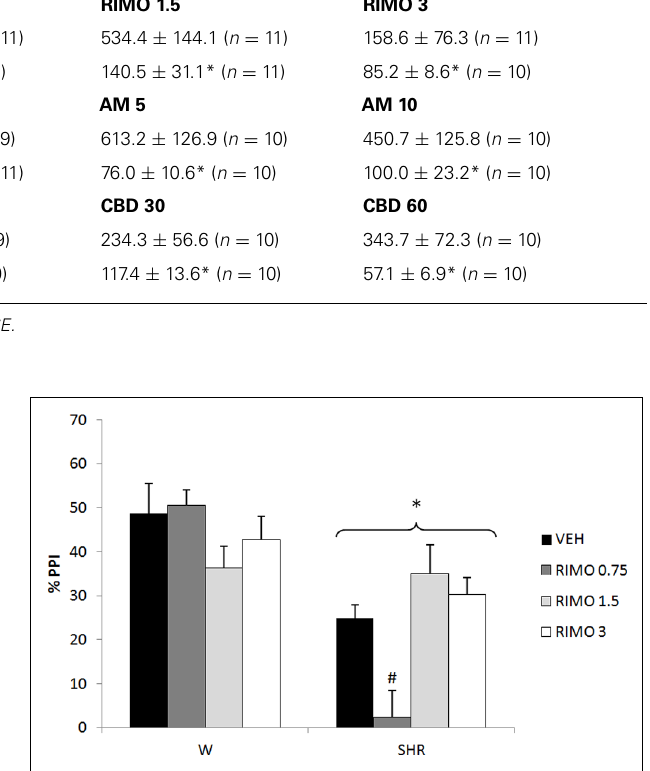
FIGURE 2 | %PPI ofWistar rats (WRs) and spontaneously hypertensive rats (SHRs) treated with vehicle (VEH), 0.75, 1.5, or 3 mg/kg rimonabant (RIMO). * p < 0.001 compared toWRs. # p < 0.05 compared toVEH group of the same strain.Three-way repeated measures ANOVA followed by Dunnett’s test. Data are reported as mean ±